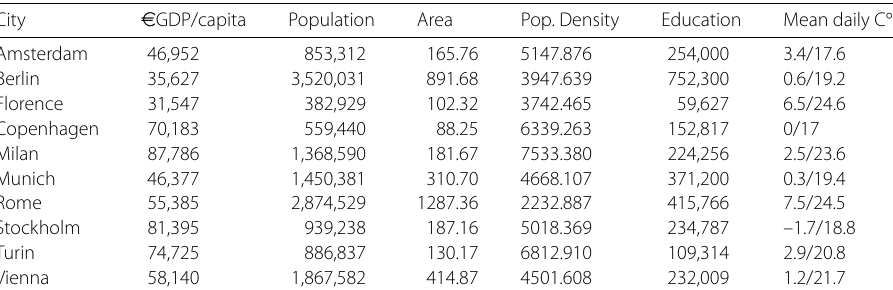
Table 1 General information on the 10 cities (area: km 2 , population density: people/km 2 ; education: persons aged 25-64 with ISCED level 5, 6, 7 or 8 as the highest level of education; mean daily temperature: minimum/maximum average daily temperature over the year). Source: Urban